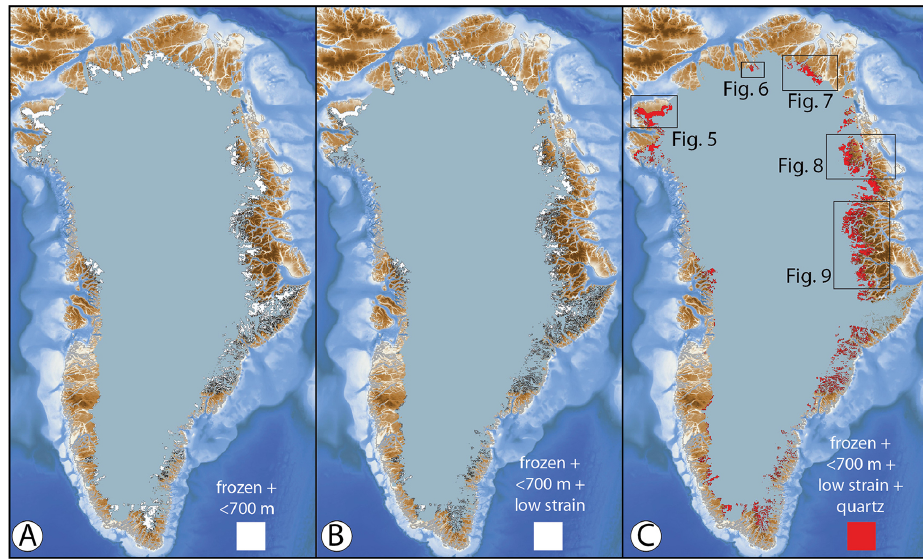
Figure 3. (a) Portion of the Greenland Ice Sheet bed (6.8%) that is both likely frozen and beneath < 700m of ice. (b) Same as in panel (a) but with a low likelihood of surface crevasses (4.8%). (c) Same as in panel (b) but with likely quartz-bearing lithologies (3.4%). Basemap topography and bathymetry from Morlighem et al.